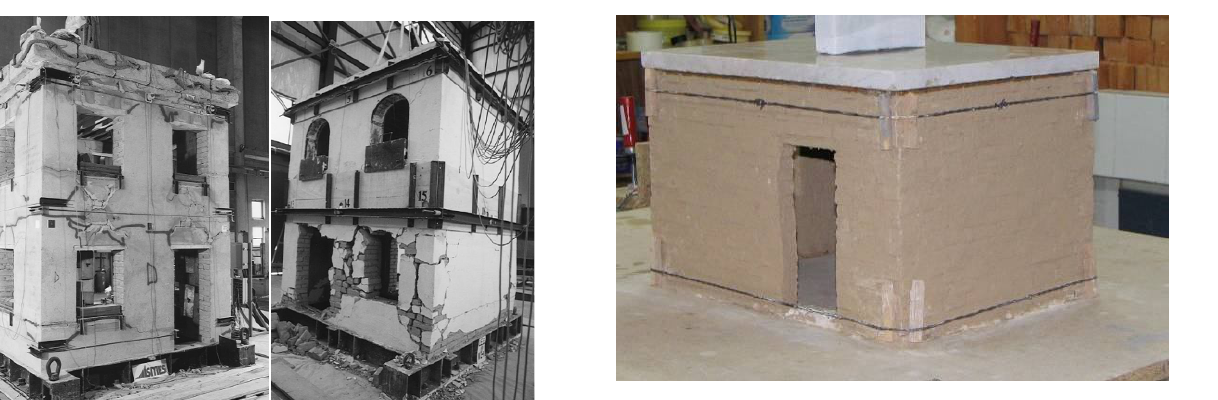
Fig. 23. Failure of specimen P1.